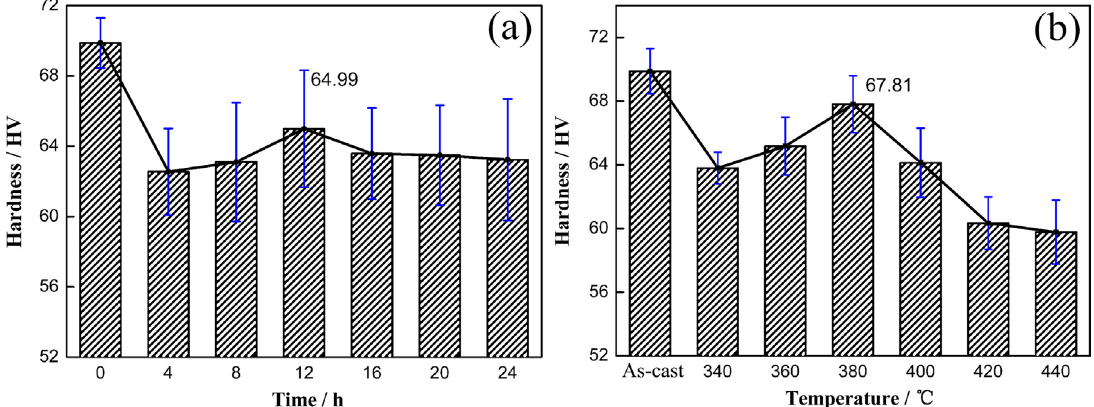
Figure 9. Evolution of Vickers microhardness after homogenization (a) microhardness versus holding time at a constant temperature of 380 ºC, (b) microhardness versus temperature at a constant holding time of 8